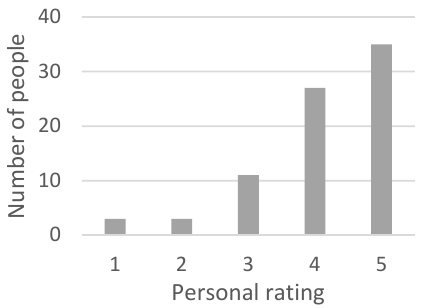
Figure A24. Perception of usefulness of the intervention, second survey (79 individuals).